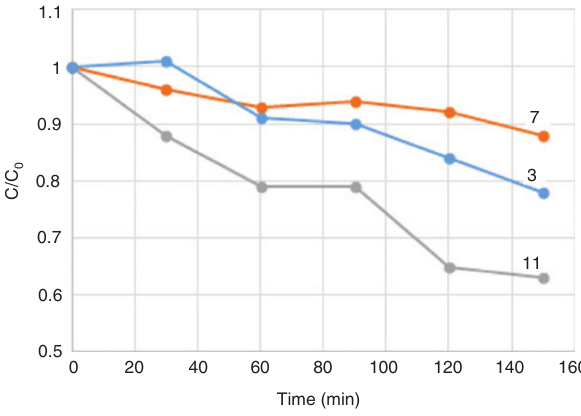
Figure 10: Influence of various pH values on STZ degradation ([STZ] = 30 mgL −1 and [CdO] = 1.1 mgL −1